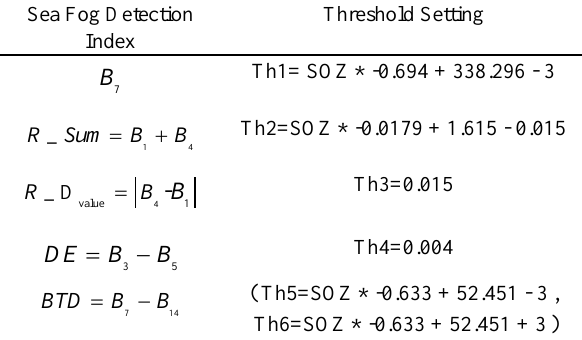
Table 2. Sea fog detection index and threshold setting used in detection algorithm at dawn and dusk